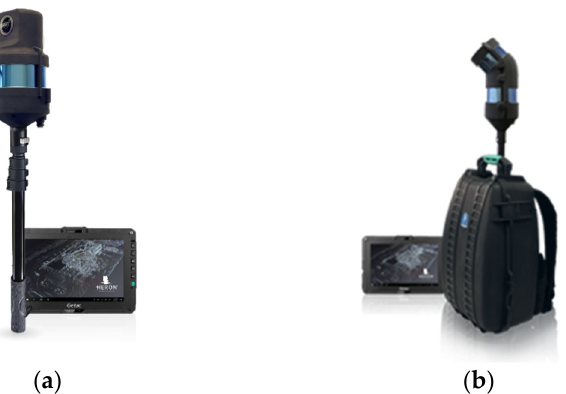
Figure 3. Handheld and wearable systems: ( a ) HERON LITE Color, ( b ) HERON MS Twin. Photos courtesy of Gexcel srl [87].